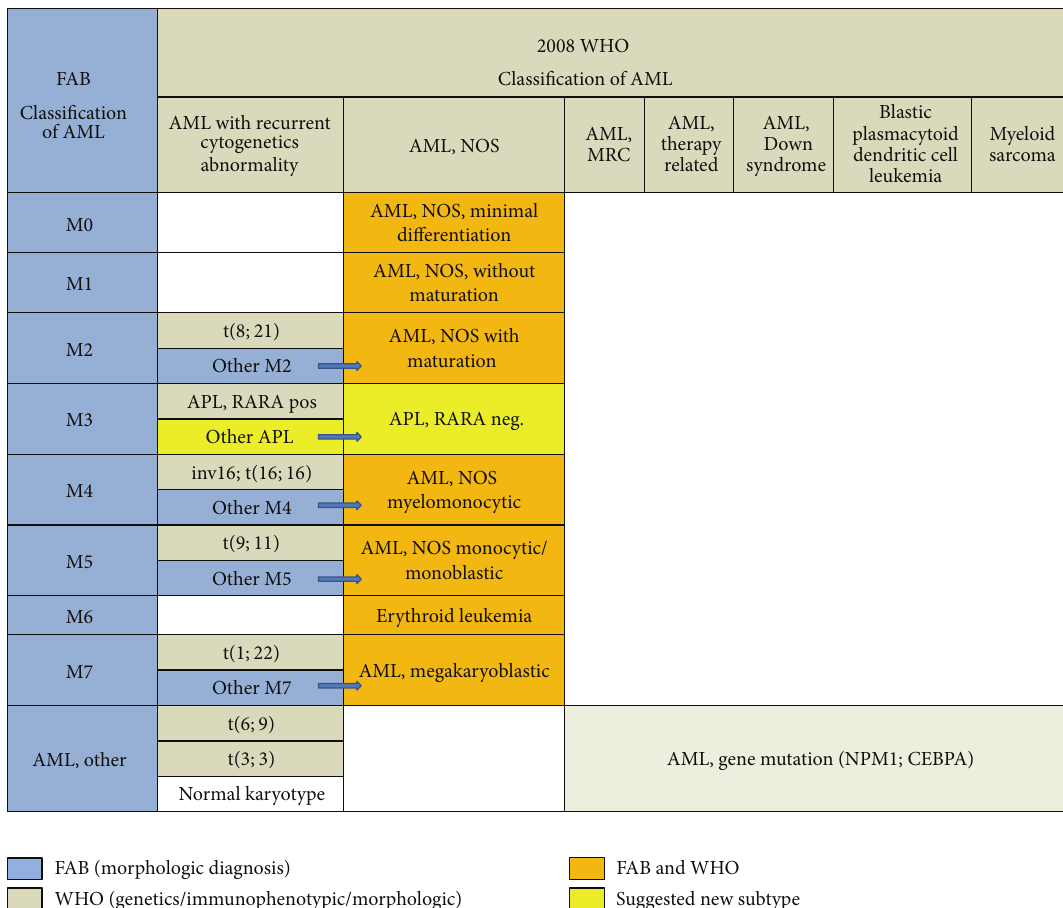
myeloblasts. In fact, myeloblasts would not have reached the 20% threshold needed to diagnose most AML subtypes, if abnormal promyelocytes were not added to blast